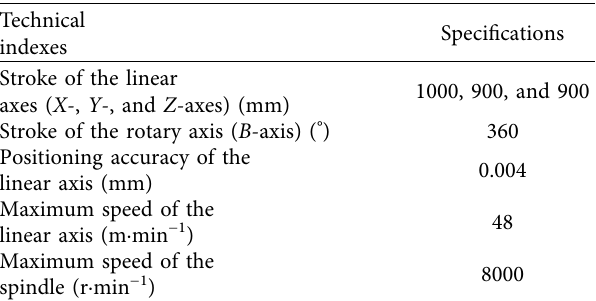
Figure 3: The flow chart of the key parameter recognition method. Table 2: Technical parameters of the four-axis machine